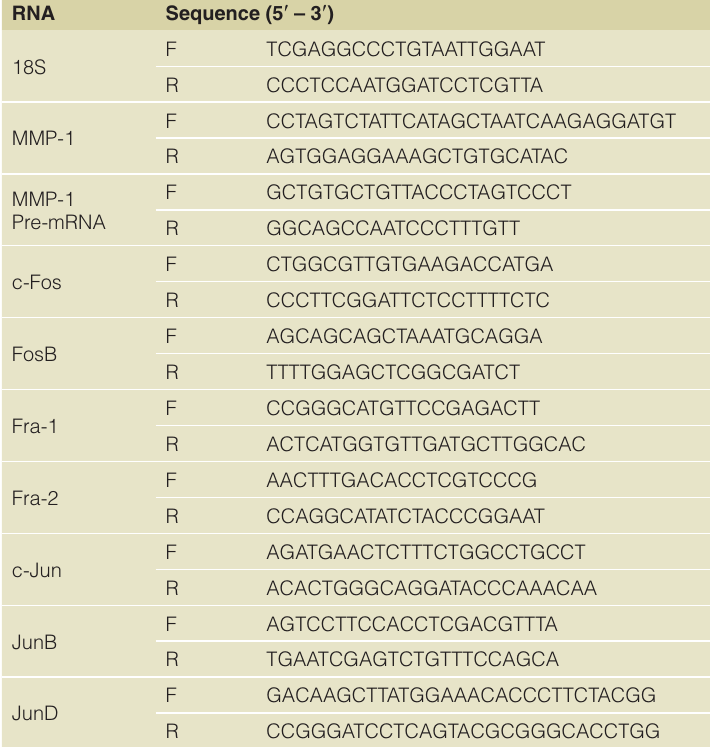
Table 1. Oligonucleotide primers used for quantitative RT-PCR.